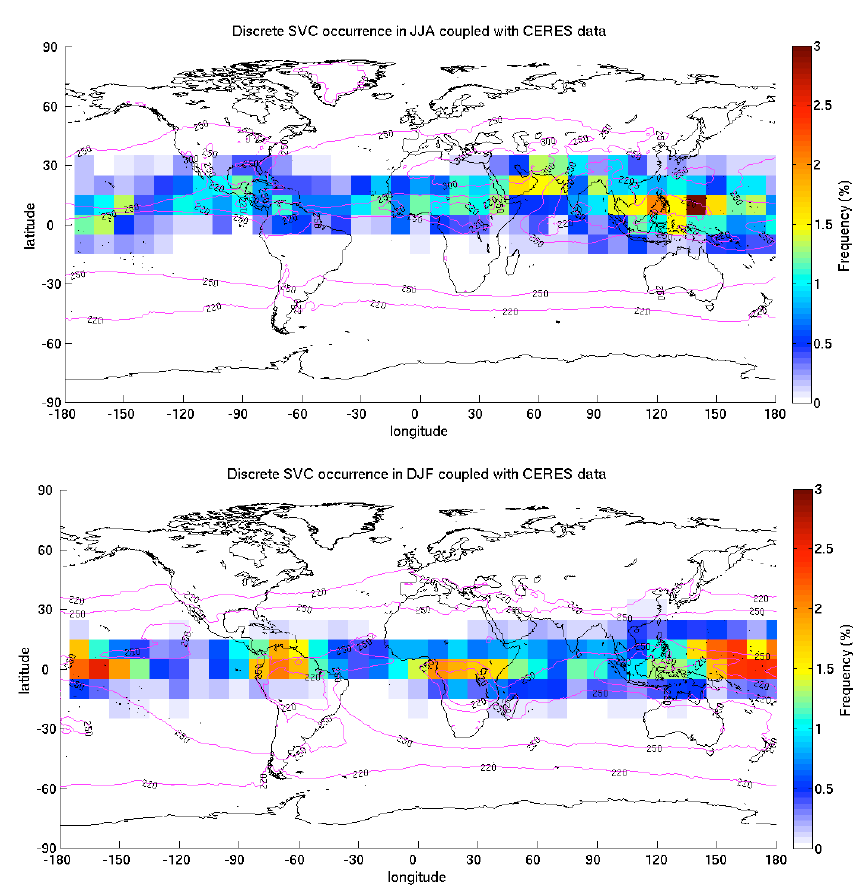
Fig. 3. Geographic distribution of SVC (in %) for JJA periods (top) and DJF (bottom) for 2006–2008. The sum of all boxes is 100%. Contour lines show top of the atmosphere outgoing longwave flux (Wm − 2 ) from CERES monthly means (EBAF product), averaged over the same Fig.%4 periods.